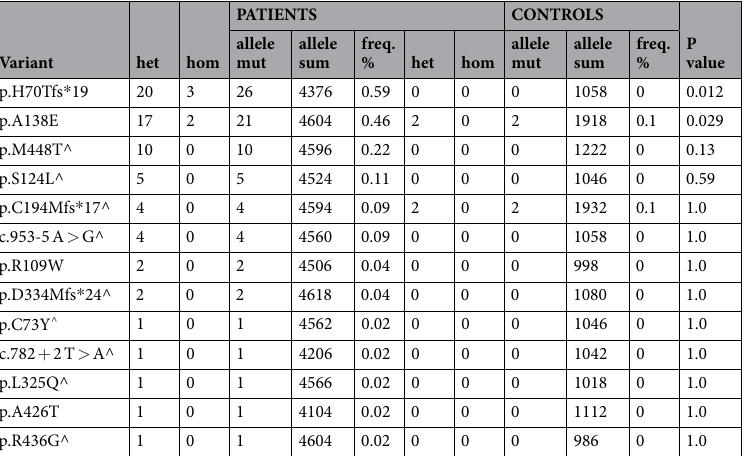
Table 1. Prevalence of rare variants in the TMPRSS3 gene detected among Polish HI patients and controls. ^Mutation not reported to date; het- heterozygous, hom- homozygous, allele mut- number of mutated alleles, allele sum - number of tested